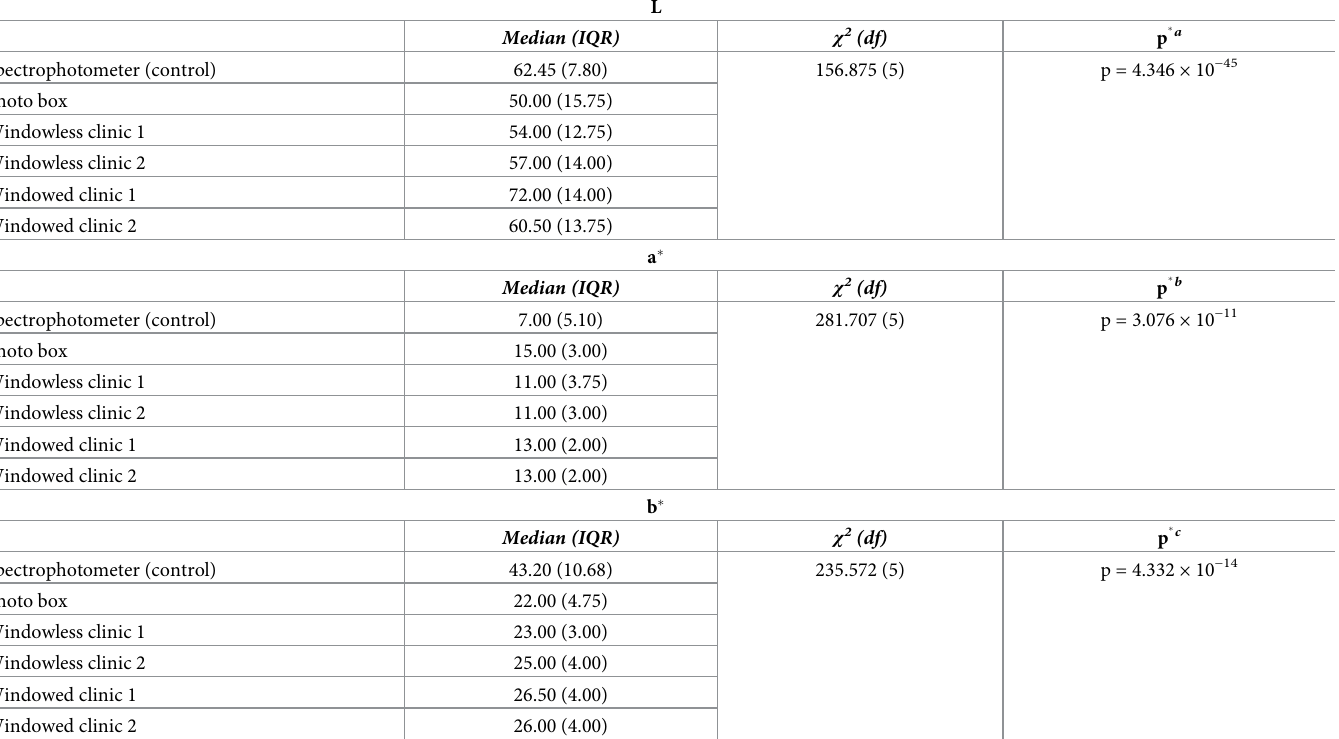
Table 3. Comparison of L, a � and b � values for images with post processing white balance correction using gray card.